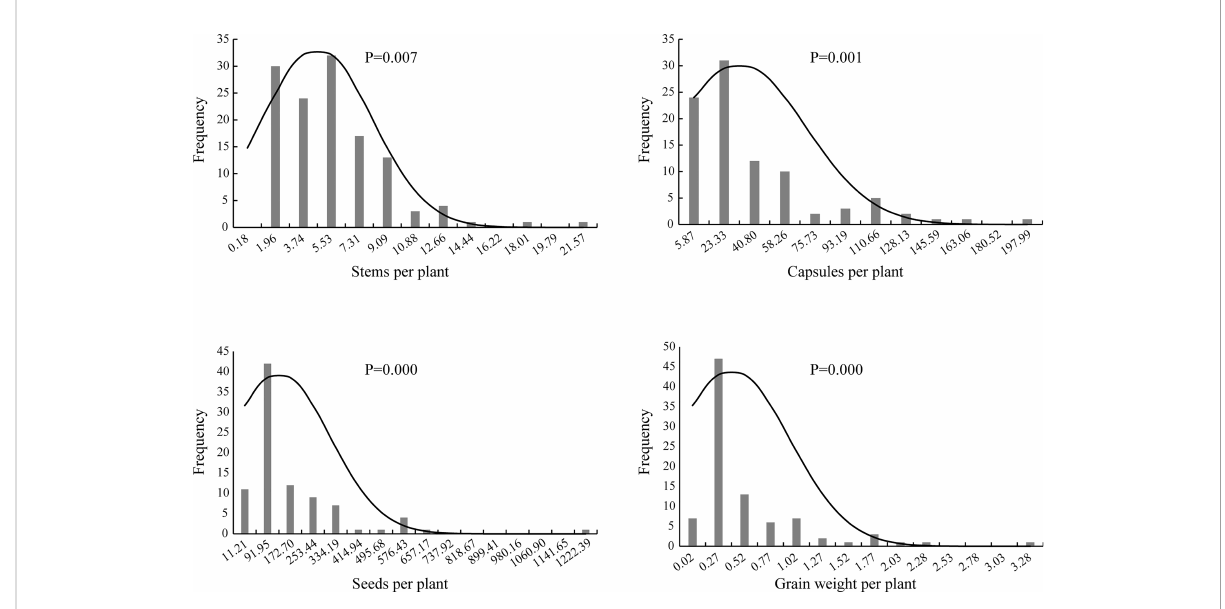
FIGURE 2 The histogram and normal distribution curve of traits per plant of F 2 population of Longya-10×pale fl ax hybridization